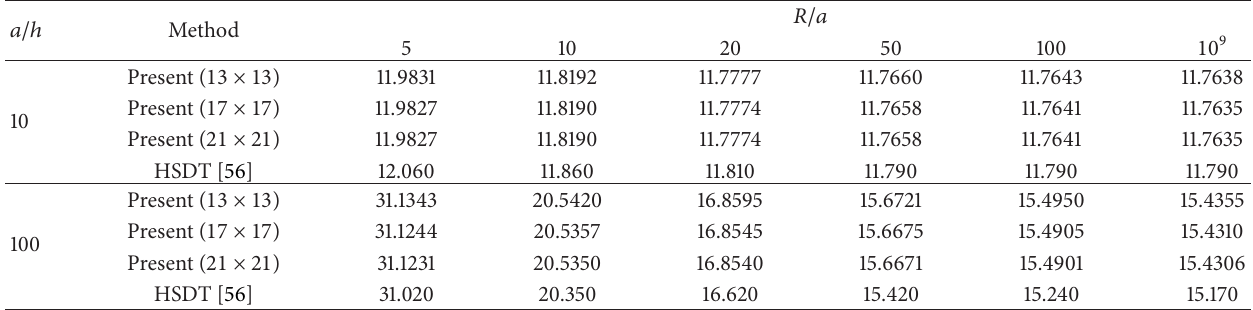
Table 3: Nondimensionalized fundamental frequencies of cross-ply laminated spherical shells, 𝜔 = 𝜔(𝑎 2 /ℎ)√𝜌/𝐸 2 , and laminate ( [0 ∘ /90 ∘ /0 ∘ ] ).